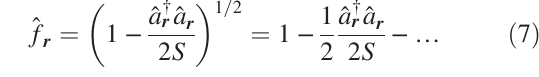
a rotation axis traces back to the DMI vectors spanning a plane. Hence, the chiral magnet breaks T 0 symmetry.